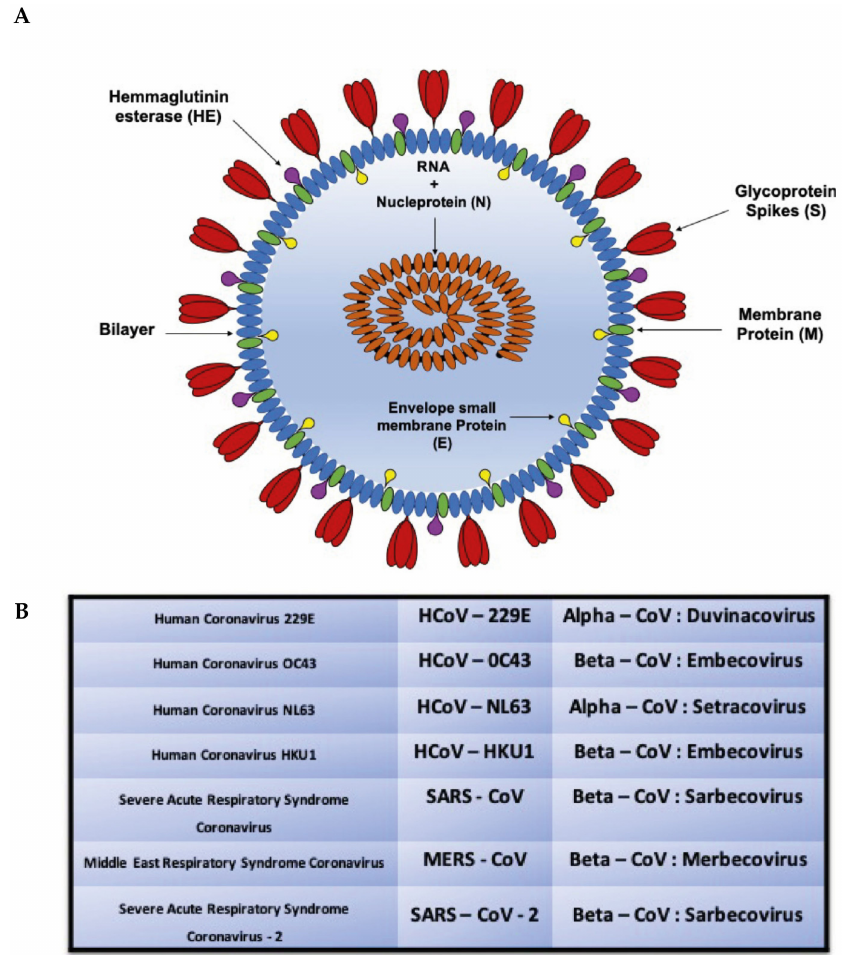
Figure 1. ( A ) Structure of the coronavirus. ( B ) The 7 Coronaviruses known to infect humans. Angeletti et al. compared the gene sequence of SARSars-Cov-2 with that of SARSars-CoV. They analyzed the transmembrane helical segments in coded ORF1ab 2 (nsp2) and nsp3 and found that position 723 has a residue of serine instead of glycine, while position 1010 is occupied by proline instead of isoleucine [36]. The issue of viral mutations is the key to explaining potential relapses